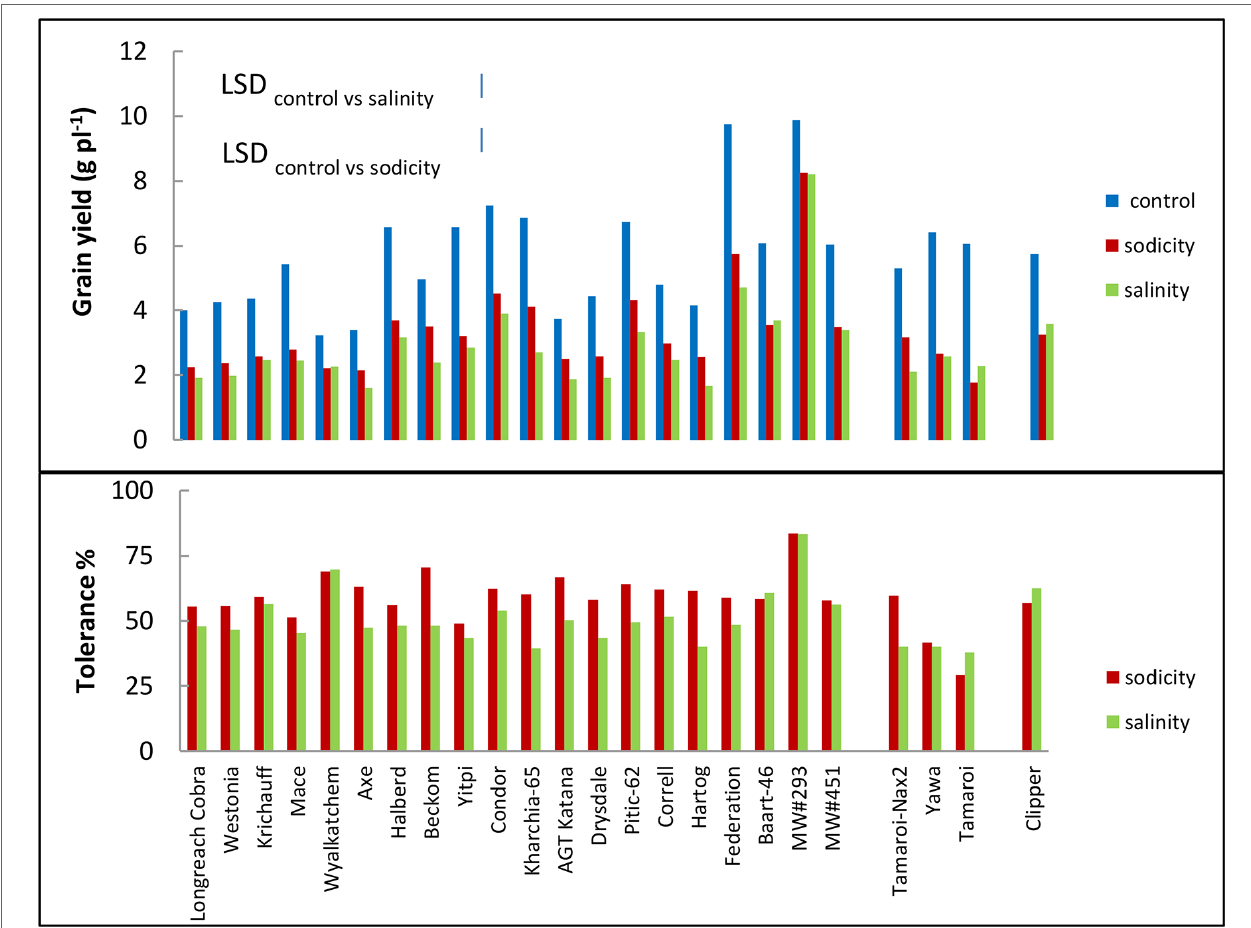
FIGURE 5 | Best linear unbiased estimates for grain yield, and tolerance (grain yield under sodicity or salinity as a percentage of grain yield under control) of 20 bread wheat entries ( Triticum aestivum L.), three durum wheat entries ( Triticum turgidum subsp durum cv. Tamaroi, Tamaroi- Nax2 and Yawa) and one barley ( Hordeum vulgare L. cv. Clipper) in Experiment 3 (n = 4). The vertical bars indicate Least Significant Difference test value at P = 0.05 for variety x treatment interaction. Entries are ordered in ascending order of leaf Na + concentration.